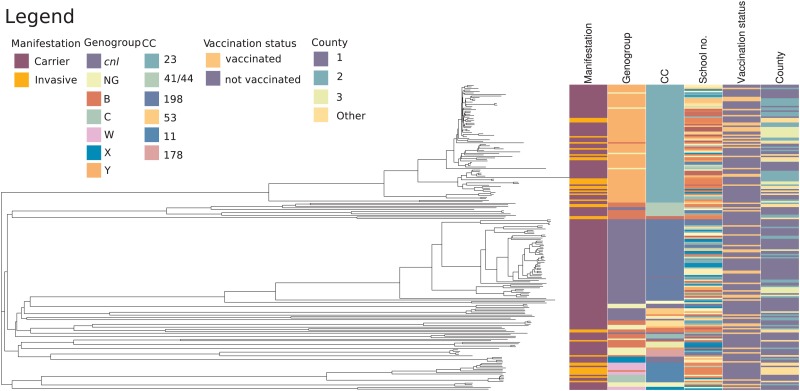
Phylogenetic relationships of the 167 N. meningitidis carriage isolates together with 35 invasive isolates from cases occurring in Norway from January 2018 to July 2019. Clinical manifestation, genogroup and clonal complex of the isolates, school number, vaccination status and county of the origin of the carriers and patients are displayed on the right. The color codes are shown in the figure. Color codes for school numbers are not listed in the legend since invasive isolates did not have school numbers. cc, clonal complex; cnl, capsule null locus; NG, non-groupable.